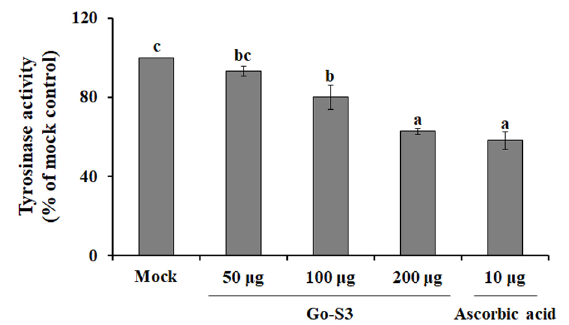
Fig. 5: Effects of Panax ginseng berry extract (Go-S3) on tyrosinase activity. Values are the average of triplicate experiments and are represented as the mean ± S.E. Tab. 3: Defined molecular docking of anthocyanins to